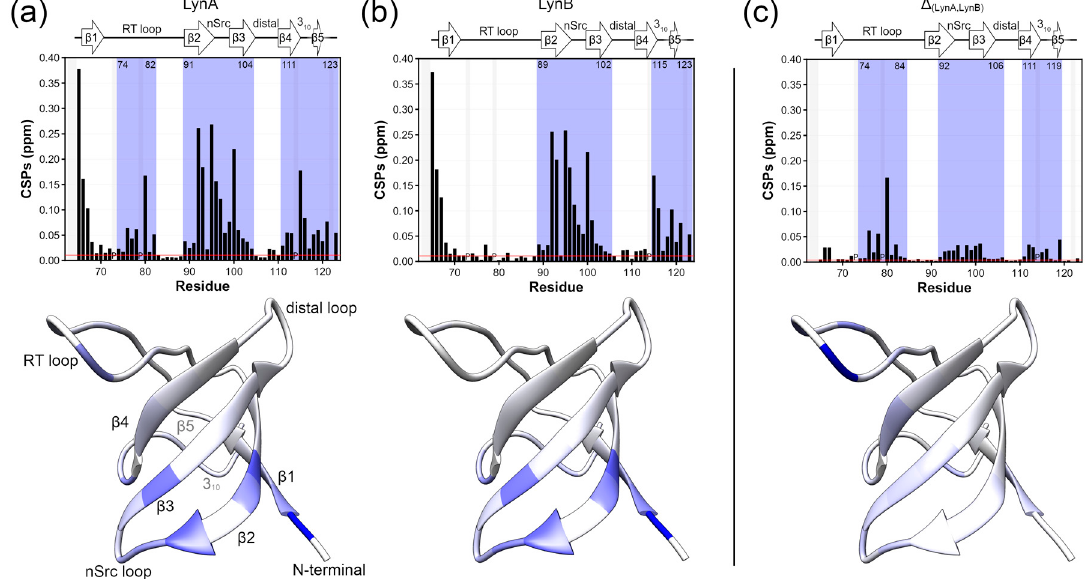
Figure 2. Interaction between the Lyn SH4-Unique Domains and the SH3 domain; for each panel ( top ) 1 H- 15 N combined chemical shift perturbations (CSPs) in ppm represented in bar plots. Proline residues are identified with “P”. ( bottom ) CSP values are mapped on the structure of the Lyn SH3 domain (PDB 1W1F) using a blue scale ranging from 0 (white) to 0.4 (most intense blue) ppm. ( a , b ) observed CSPs in the SH3 domain within the USH3 constructs with respect to the Lyn USH3 isolated domain for LynA and LynB, respectively. Residue numbers in LynB have been modified to match those of LynA. The blue shade in bar plots represents the continuous regions where perturbations are significant, as defined in materials and methods and based on the threshold represented by the red line. The threshold value is the average plus 5 standard deviations of the 10% lowest CSPs ( c ) The difference between CSPs values in ( a , b ). The mapping of the differential CSPs ( c , bottom ) is in a scale ranging from 0 to 0.15 ppm.